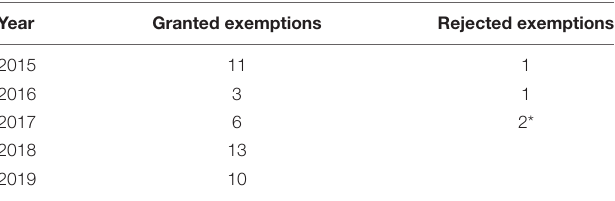
TABLE 2 | Exemption applications granted and rejected, in Skåne